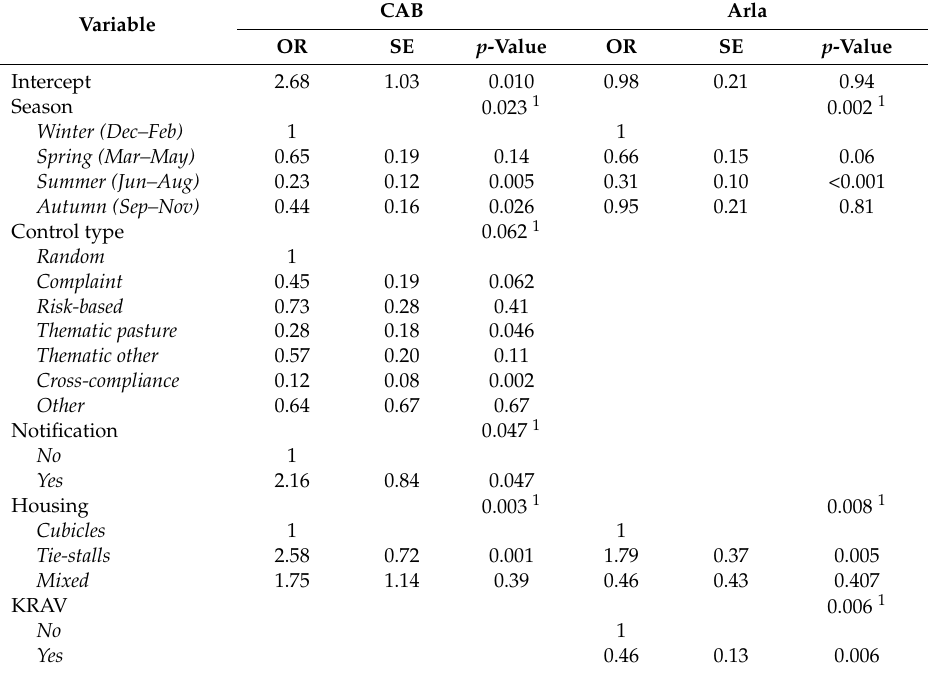
1 Joint Chi-square test of